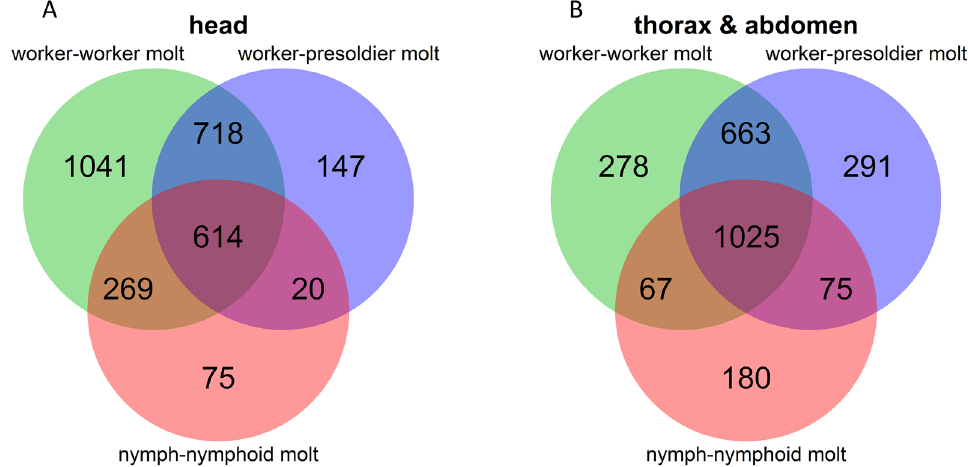
Figure 2. Venn diagram showing the numbers of differentially expressed and co-expressed genes among worker-worker molt, worker-presoldier molt and nymph-nymphoid molt in head ( A ) and body (thorax and abdomen) ( B